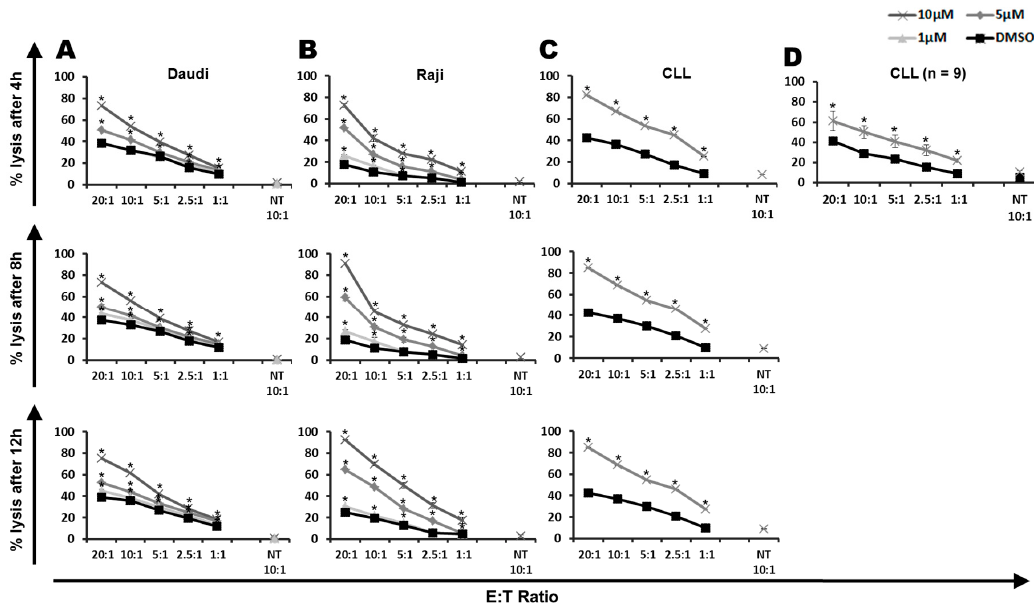
Figure 1. Influence of PipFcB on the cytotoxic capacity of chimeric antigen receptor T cells (CARTs) against Burkitt lymphoma lines and primary chronic lymphocytic leukemia (CLL) cells. Cytotoxicity of CD19-specific CARTs was determined by 51 Cr release assay after co-culture with the CD19+ Burkitt lymphoma cell lines Daudi ( A ) and Raji ( B ), as well as primary CLL cells ( C ). Co-incubation with CART cells in different effector to target ratios (20:1, 10:1, 5:1, 2.5:1, 1:1) and non-transduced T cells (NT) was performed for 4 h, 8 h, and 12 h. Different concentrations of the specific reactive oxygen species (ROS) accelerator PipFcB (10 µM, 5 µM, 1 µM) or dimethyl sulfoxide (DMSO; vehicle) were added simultaneously with CARTs to the culture. Synergistic effects of CARTs with PipFcB were seen in all concentrations (1–10µM) and incubation times (4–12 h). Evaluation of primary CLL cells from nine different patient samples validated the synergistic effects of the combination of CARTs with PipFcB in primary leukemia cells ( D ). All experiments were performed in triplicates. Primary CLL cells were evaluated in nine independent experiments. Mean values were calculated for each group; error bars indicate standard deviation (* p < 0.05).